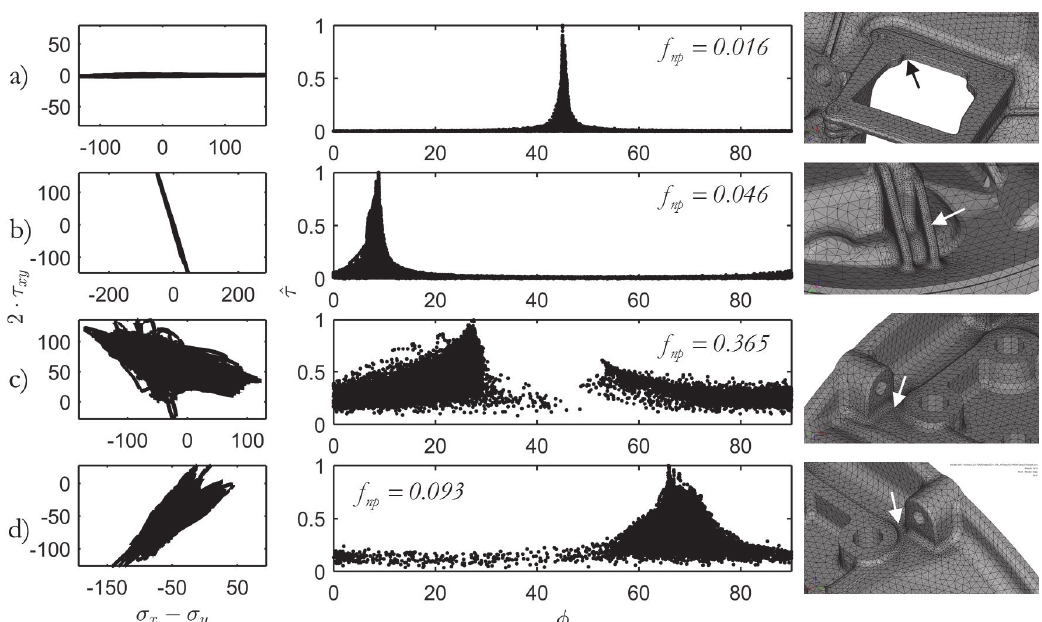
Figure 2: Tresca-diagram (left), changes of maximum shear planes (middle) and corresponding crack initiation site (right). Four significant examples are extracted from the internal database and discussed in detail. The local stress paths at the t t ˆ ( )/ max( ( )) over the crack initiation sites are displayed on the left of Fig. 2. The normalized maximum shear    max max corresponding angle  is plotted in the middle of this figure. Examples a and b indicate an almost uniaxial stress state with small changes in principal directions, which corresponds to small rotation of the planes of maximum shear. The NPFs at the crack initiation sites are 0.016 and 0.046, respectively. The crack initiation sites are located at a milled-out portion (a) and a die-cast rib (b). At examples c and d the crack initiation sites are located at a notch between two flanges. f 0 3 . ). However, there are large differences in the Both of them have almost the same out-of-phase extent (  PC np